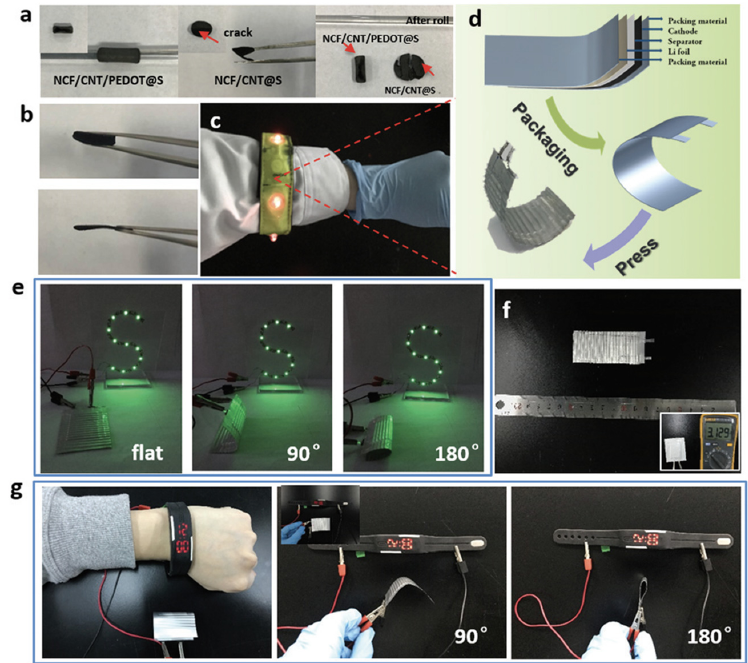
Figure 17. Applications of flexible batteries in charging LEDs, a flexible bracelet, and a smart watch. ( a ) Photographs of the freestanding NCF/CNT/PEDOT@S and NCF/CNT@S electrodes curled around a glass rod. ( b ) Photographs of the freestanding NCF/CNT/PEDOT@S electrodes before (top) and after (below) pressing. ( c ) Powering a flexible bracelet. ( d ) Schematic of the structure of the flexible battery. ( e ) Photographs of the soft-package Li–S battery lighting up 11 LEDs. ( f ) Size of the flexible battery for a bracelet (inset: initial voltage output of the flexible battery). ( g ) Powering a smart bracelet with the flexible NCF/CNT/PEDOT@S battery at 90° and 180° (inset: flat state). Reprinted with permission from reference [241] . Copyright (2018) RSC Pub.